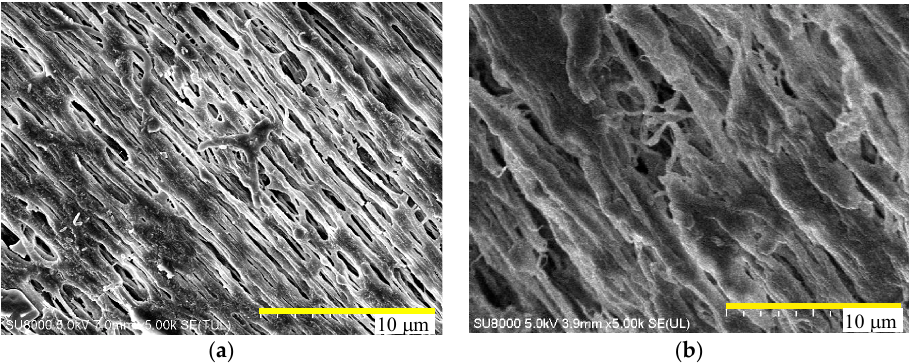
Figure 8. SEM images of the EuroSep PP membrane wall: ( a ) internal surface and ( b ) external surface.